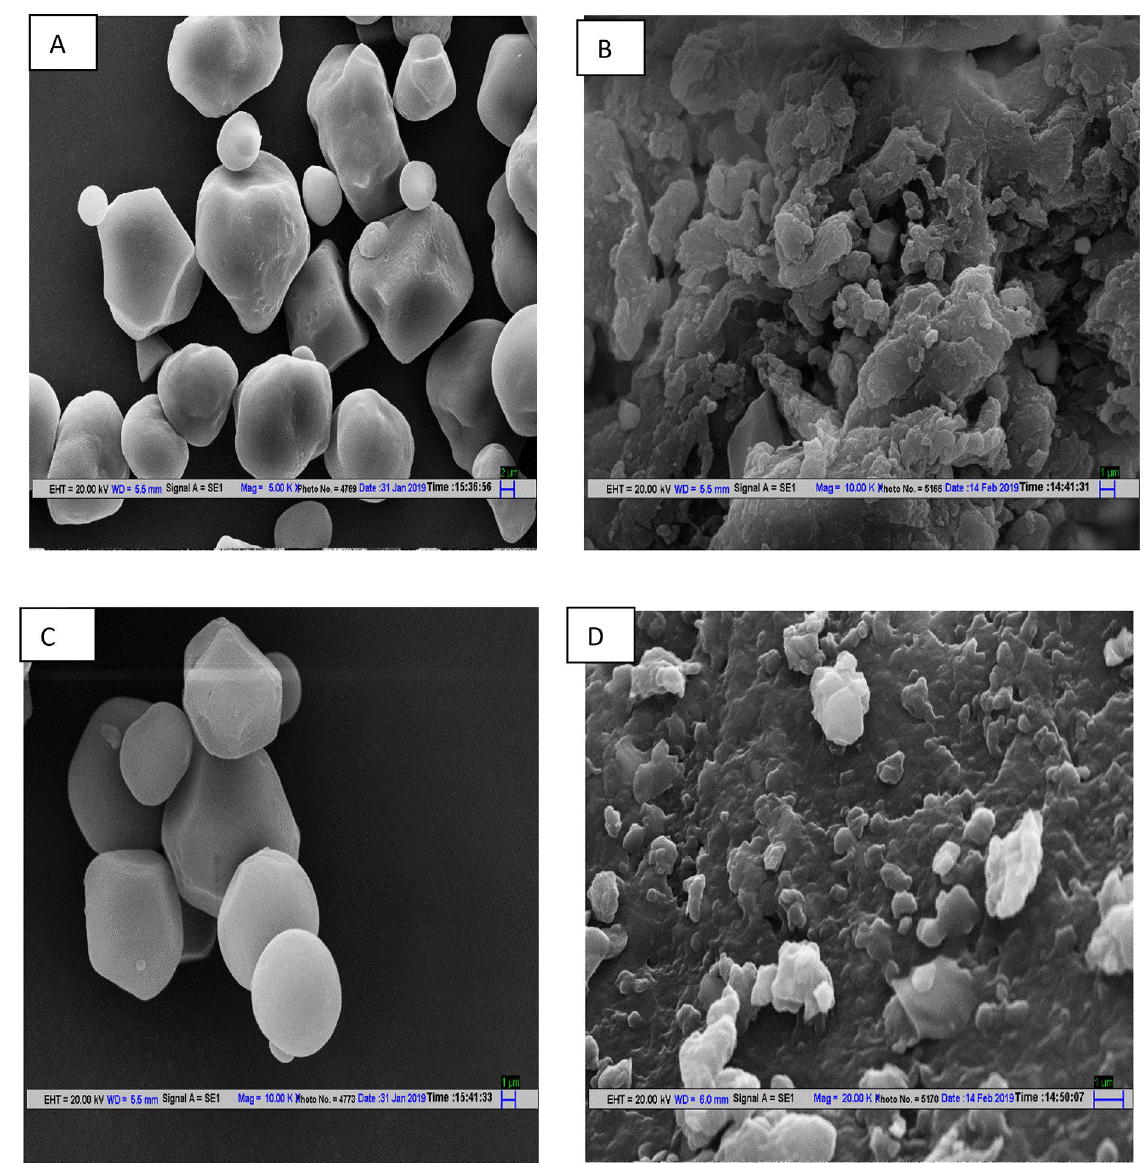
Figure 1. (a–d) Scanning electron micrographs of native foxtail starch (a) nano-reduced foxtail starch (b) native sorghum starch (c) and nano sorghum starch (d)